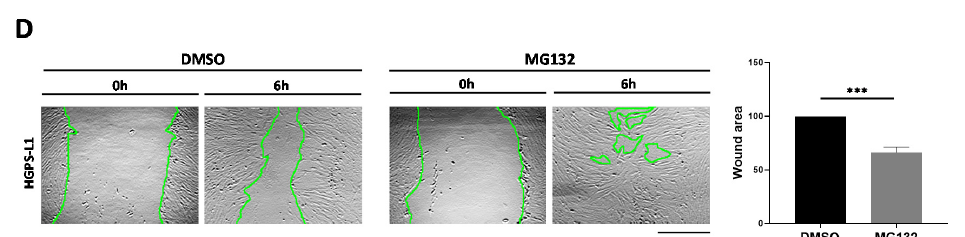
Figure 3. MG132 reduces senescence and enhances proliferation and migration in HGPS-like and MAD-B patients’ cells. ( A ) Luminescence-based quantification of senescence rate in WT, HGPS-like, and MAD-B fibroblasts treated with 500 nM MG132 for 96 h relative to DMSO-treated cells. Each experiment was performed on cells at the same passage level. Senescence is determined as relative light units (RLUs). (mean ± SEM, n = 3, Student’s t -test, * p < 0.05, ** p < 0.01. MG132-treated vs. DMSO-treated cells). ( B ) Colorimetric detection of senescence-associated β galactosidase in HGPS-like and MAD-B fibroblasts treated with 500 nM MG132 for 96 h relative to DMSO-treated cells. Each experiment was performed on cells at the same passage level. β -galactosidase blue staining is lower in cells treated with MG132 compared to cells treated with DMSO. ( C ) Cell proliferation rate based on the incorporation of bromodeoxyuridine (BrdU) into the DNA was expressed as absorbance OD 450 nm. ( D ) Left panel: an example of wound healing assay performed on HGPS-L1 fibroblasts treated for 6 h with DMSO or MG132 (500 nM). Right panel: the results of wound healing assays on individual samples (Figure S1) were grouped into biological replicates (1 HGPS, 6 HGPS-like, and 1 MAD-B) to perform statistical tests. (mean ± SEM, n = 8, Student’s t -test, *** p < 0.001. MG132-treated vs. DMSO-treated cells). Results are expressed as a percentage of the area of the original wound and normalized to DMSO-treated cells, considered as 100%. Scale bar, 100 µ